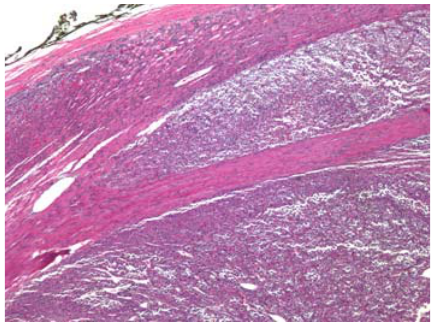
Figure 2: 40x magnification: the tumor shows partial invasion through the tumor capsule, indicating at least borderline malignant potential.